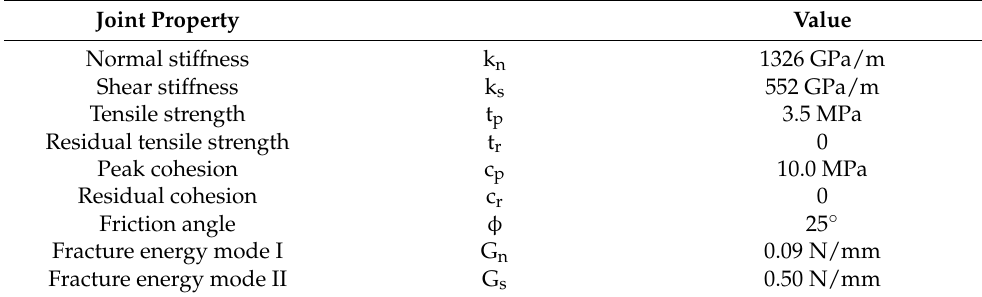
Table 2. Joint properties of base